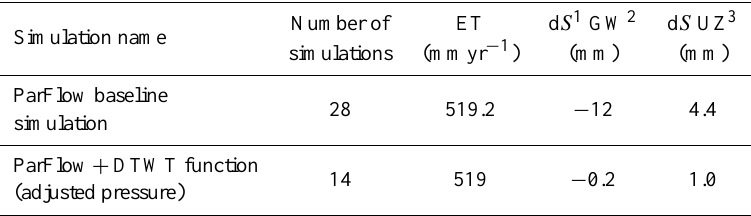
Table 2. Baldry sub-catchment annual water balance for the equilibrium year after the baseline spin-up approach and the hybrid approach, with the adjusted pressure head distribution option above the water table. Annual precipitation is